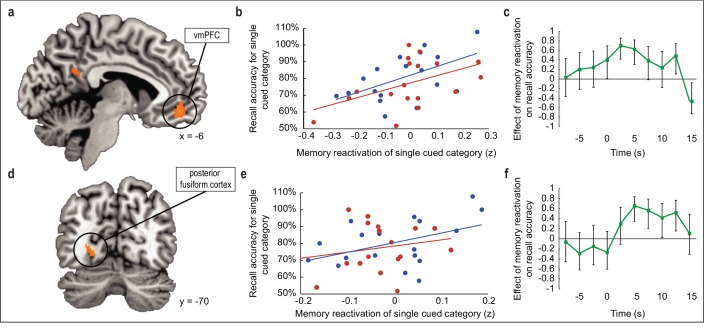
Relationship between odor-evoked memory reactivation in sleep and posttest memory retention.(a,d) During SWS, the extent to which odors evoked category-specific memory reactivation in vmPFC (a) and posterior fusiform cortex (d) was significantly correlated with behavioral enhancement of cued visuospatial memory retrieval at posttest. fMRI activity is shown at p < 0.001 uncorrected, and images are overlaid on a canonical single-subject T1-weighted MRI scan. (b,e) Correlations between fMRI memory reactivation of an individual object category and recall accuracy for that category at posttest, for the two reactivated object categories taken separately in vmPFC (b) and posterior fusiform cortex (e). Blue and red dots represent individual object categories, where category assignment is arbitrary. (c,f) Illustration of correlation depicted in (a,d) across time points in vmPFC (c) and posterior fusiform cortex (f). Time 0 is aligned to odor onset. Error bars depict 90% confidence intervals.10.7554/eLife.39681.019Figure 3—source data 1.Relates to panel (b).10.7554/eLife.39681.020Figure 3—source data 2.Relates to panel (c).10.7554/eLife.39681.021Figure 3—source data 3.Relates to panel (e).10.7554/eLife.39681.022Figure 3—source data 4.Relates to panel (f).